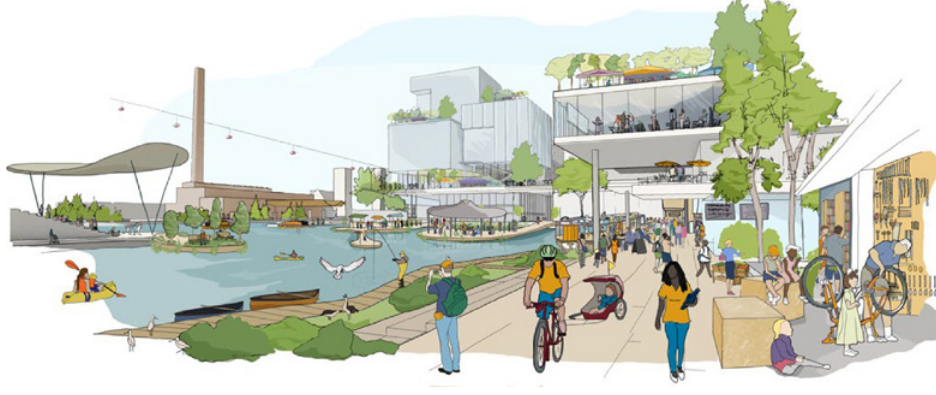
Figure 6 Visual intent (Sidewalk Labs, 2017, p.25). Credit: Sidewalk